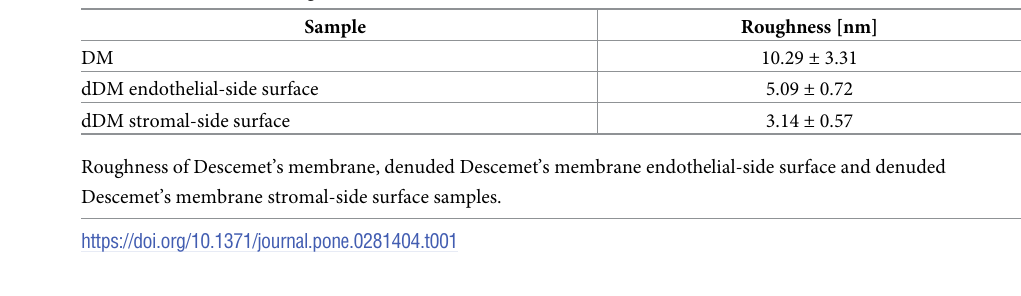
Table 1. Calculation of roughness.